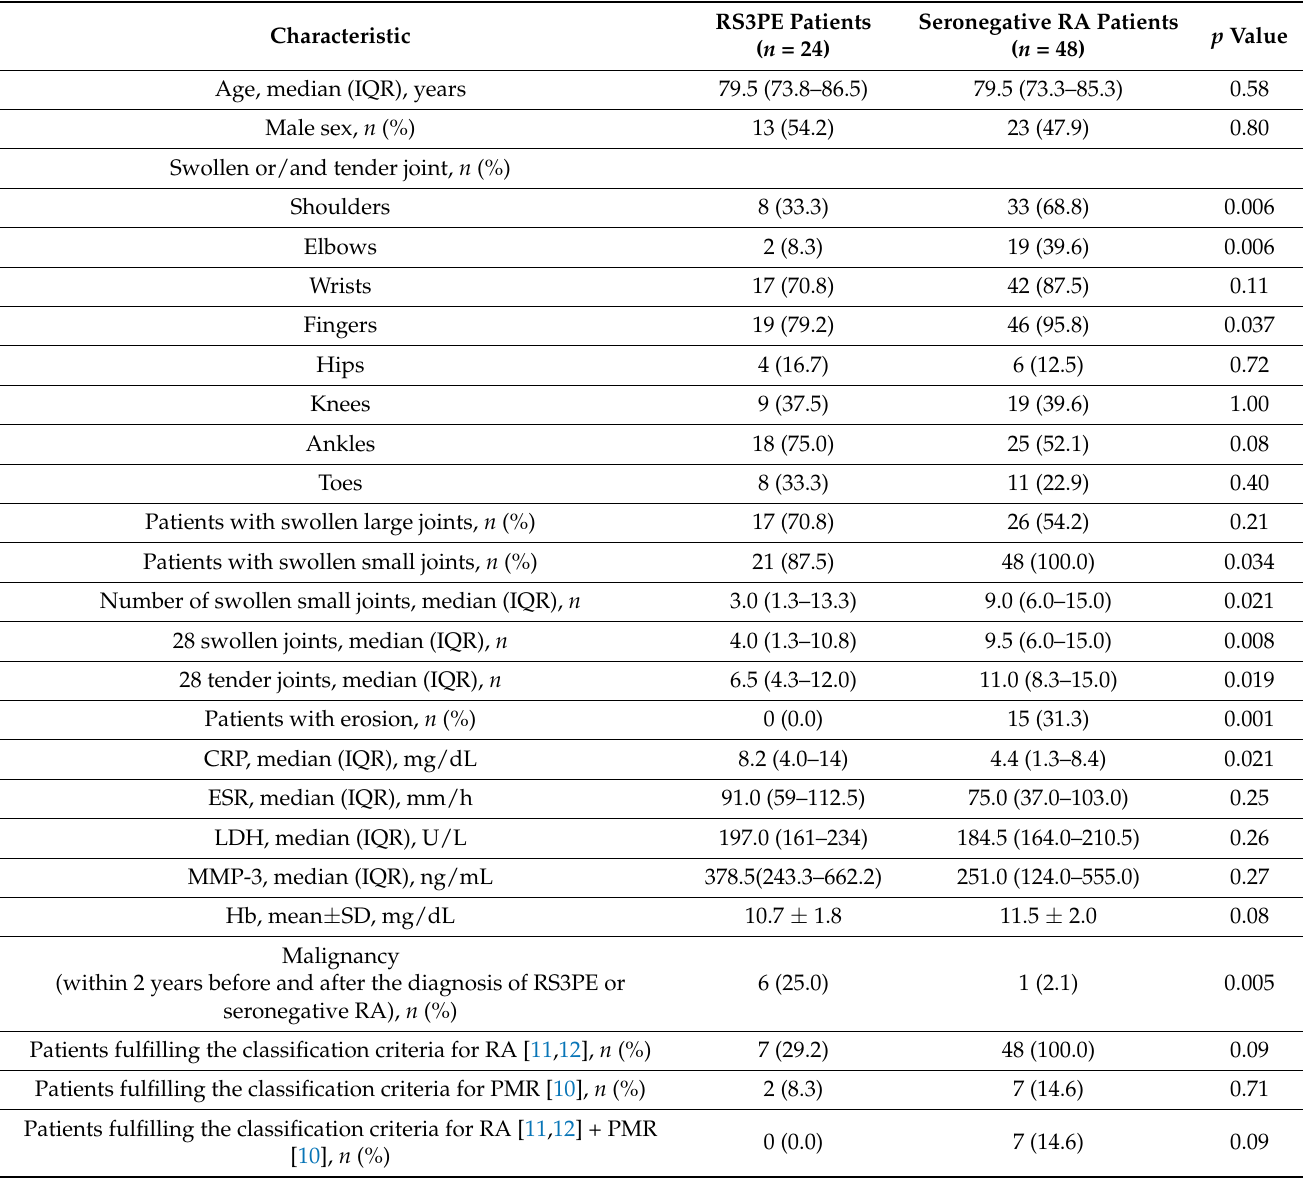
Table 3. Baseline characteristics at diagnosis of RS3PE and seronegative RA patients with a 1:2 matching for age and sex.